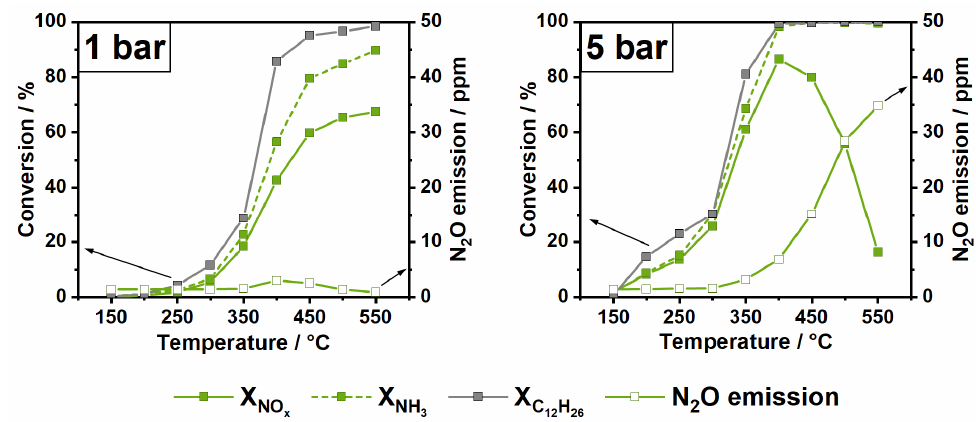
Figure 6. NO x /NH 3 /C 12 H 26 conversion and N 2 O emission over Fe-ZSM-5 for 1 bar (left) and 5 bar (right) in a standard SCR gas mixture.